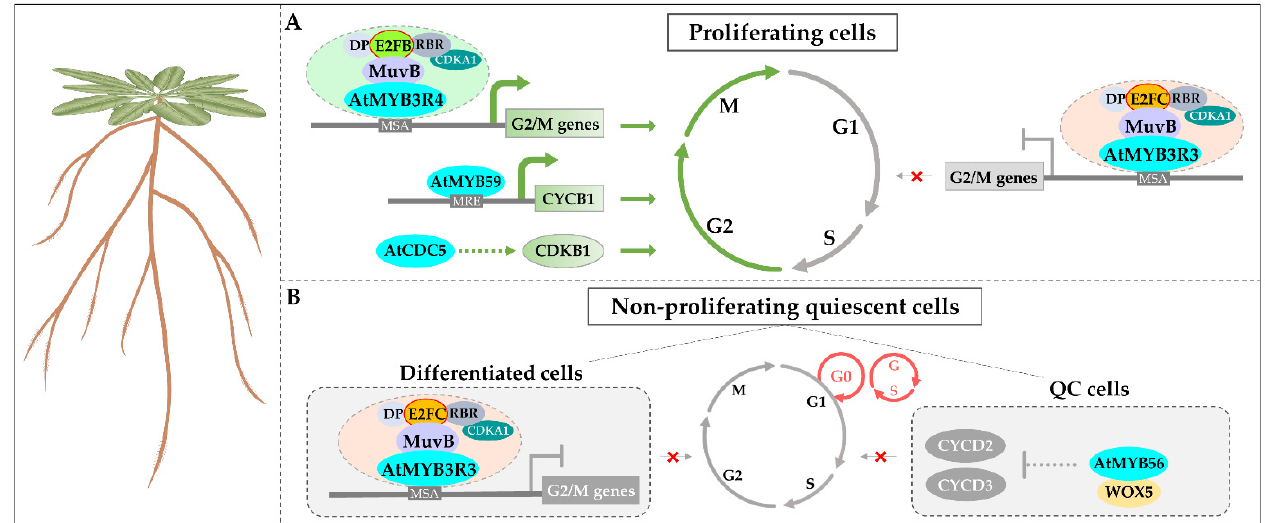
Figure 2. MYB TFs regulate the cell cycle in Arabidopsis roots. ( A ) In proliferating cells, AtMYB3R4 activates the expression of G2/M-specific genes by interacting with the DREAM complex containing E2FB at the G2/M phase, while AtMYB3R3 interacts with the DREAM complex containing E2FC to inhibit G2/M-specific gene expression at the G1/S phase. AtMYB59 activates CYCB1 to promote G2/M transition in the root apical meristem (RAM). AtCDC5 participates in cell cycle progression by positively regulating CDKB1 expression at the G2/M phase in RAM. ( B ) In non-proliferating quiescent cells, AtMYB3R3 interacts with the DREAM complex containing E2FC to inhibit the expression of G2/M-specific genes to maintain the quiescent state in differentiated cells; AtMYB56 represses the expression of CYCD2 and CYCD3 genes by interacting with WOX5 to maintain a low division rate of quiescent center cells. The blue dots represent MYB proteins.